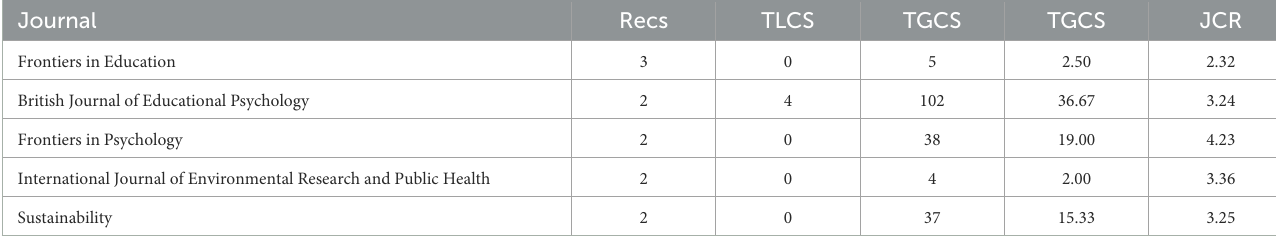
TABLE 2 Journals by the number of publications and citations received (TLCS and TGCS) and impact factor (JCR) [76] ( ≥ 2